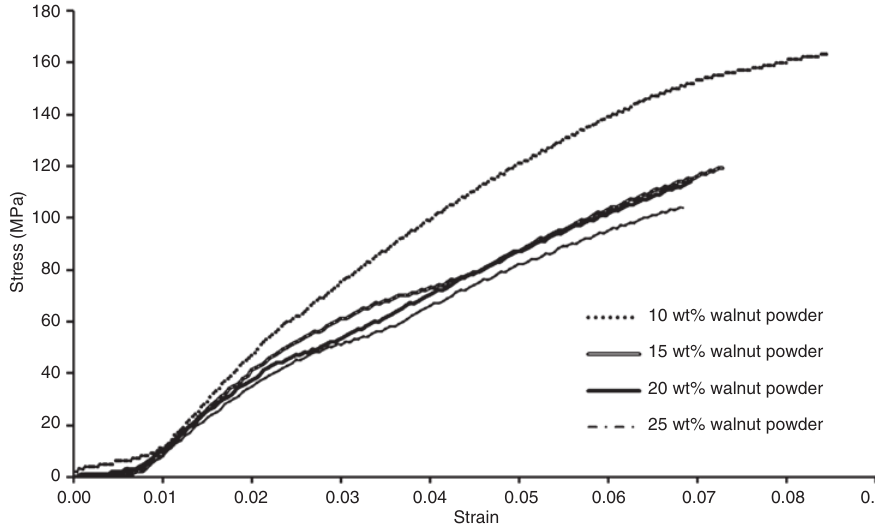
Figure 2 Stress-strain diagram under tension for different wt% of walnut particles.